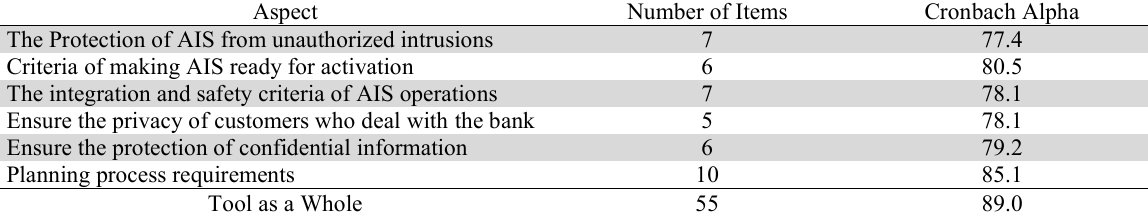
Internal stability coefficients (Cronbach Alpha) for each area of the study tool and the tool as a whole Aspect Number of Items